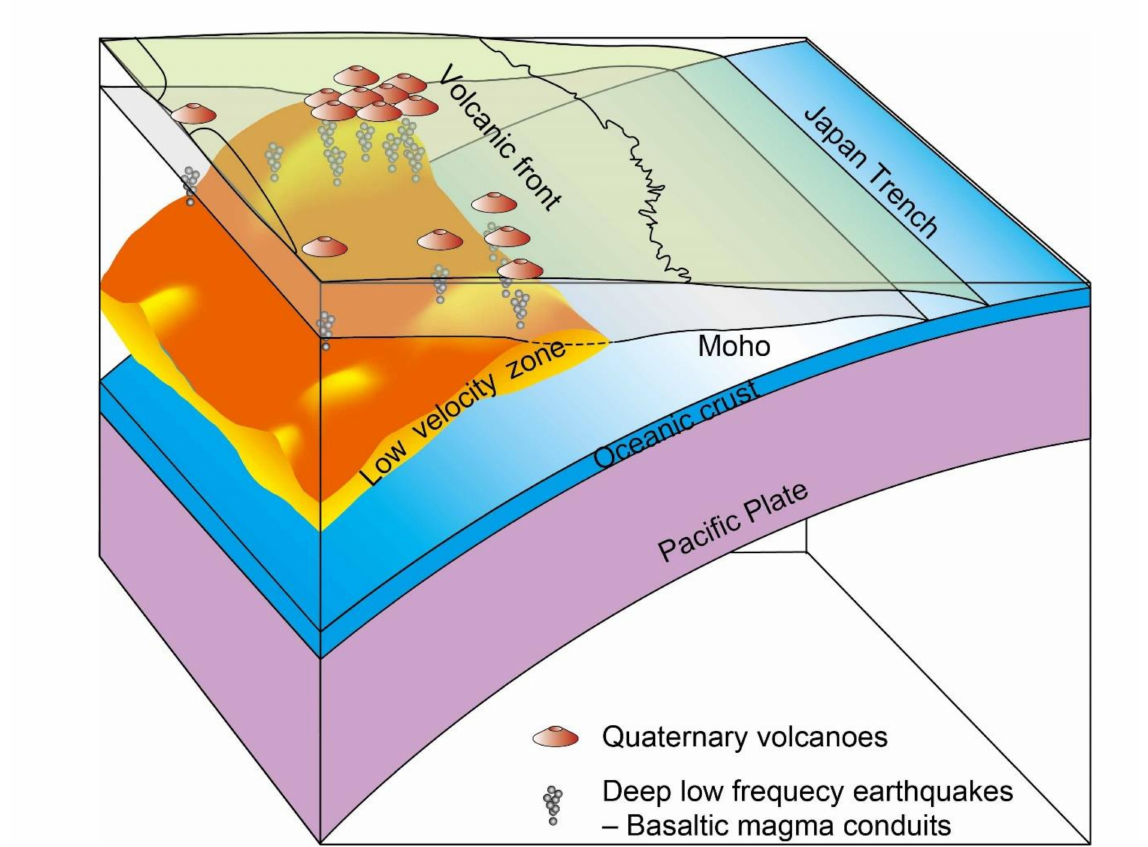
Figure 5. A conceptual model of the sporadic LFEs clusters as rising basaltic magma conduits from the continuous low-velocity zone in northeastern Japan. The low-velocity zone was roughly sketched from